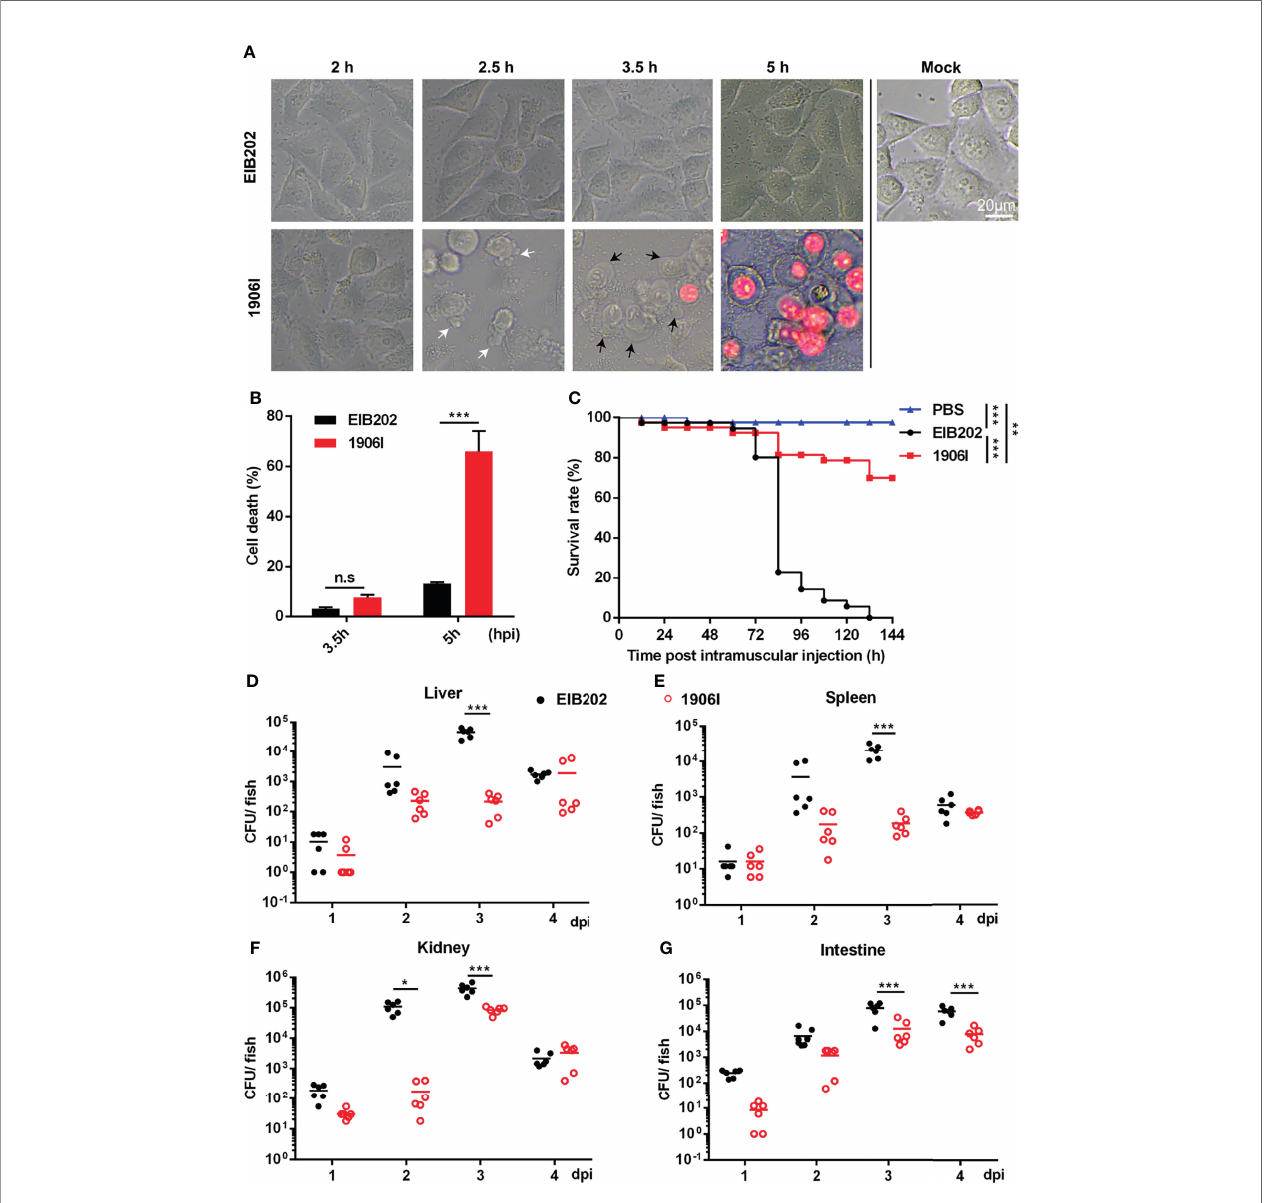
FIGURE 1 | E. piscicida 1906I induced robust membrane-ruptured cell death and showed attenuated bacterial colonization and virulence in zebra fi sh. (A) Dynamic changes of HeLa cell morphology after infection of wild-type EIB202 or mutant 1906I at an MOI of 25 for the indicated time. White arrows denote the membrane bebbling and black arrows denote membrane swelling and rounding. Propidium iodide (PI) was added to detect the loss of plasma membrane integrity. Scale bar, 20 m m. (B) Lactate dehydrogenase (LDH) release of HeLa cells infected with EIB202 or 1906I for the indicated time. (C – G) Adult zebra fi sh were intramuscular injected with 50 CFU indicated E. piscicida strains per fi sh. (C) Survival of zebra fi sh was monitored for 6 days. PBS as control. ( n =35). (D – G) Bacteria colonization in liver (D) , spleen (E) , kidney (F) and intestine (G) of the indicated time points post infection. Five surviving adult zebra fi sh were pooled as a sample and dissected at the indicated time point post infection, and livers, spleens, kidneys, and intestines were collected and grinded to homogenates for CFU counts, respectively. Results are representative of at least three independent experiments. * P < 0.05, ** P < 0.01, *** P < 0.001; n.s, not signi fi cant. [Gehan-Breslow-Wilcoxon test for panel (C) , Two-way ANOVA for panels (B, D – G)